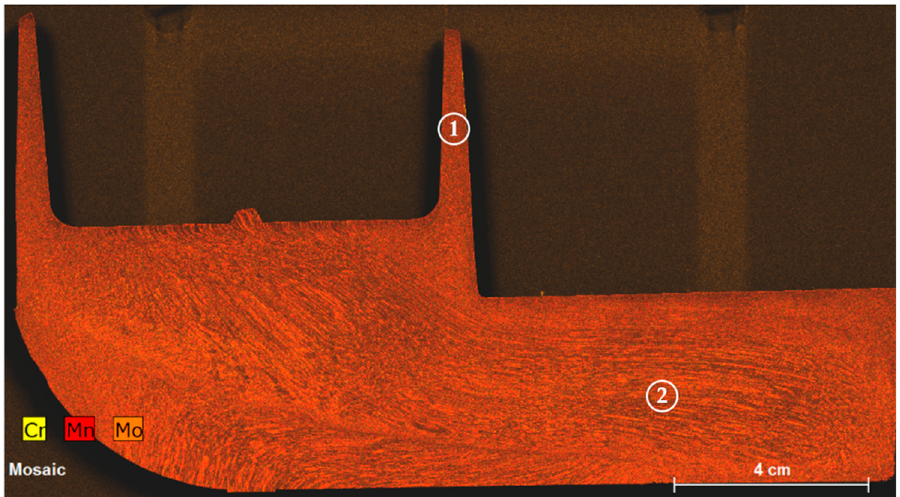
Figure 12. X-ray fluorescence (XRF) analysis of the slice taken from the component manufactured with the 42CrMo4. Zone 1 and 2 are the cup and bulk regions respectively.